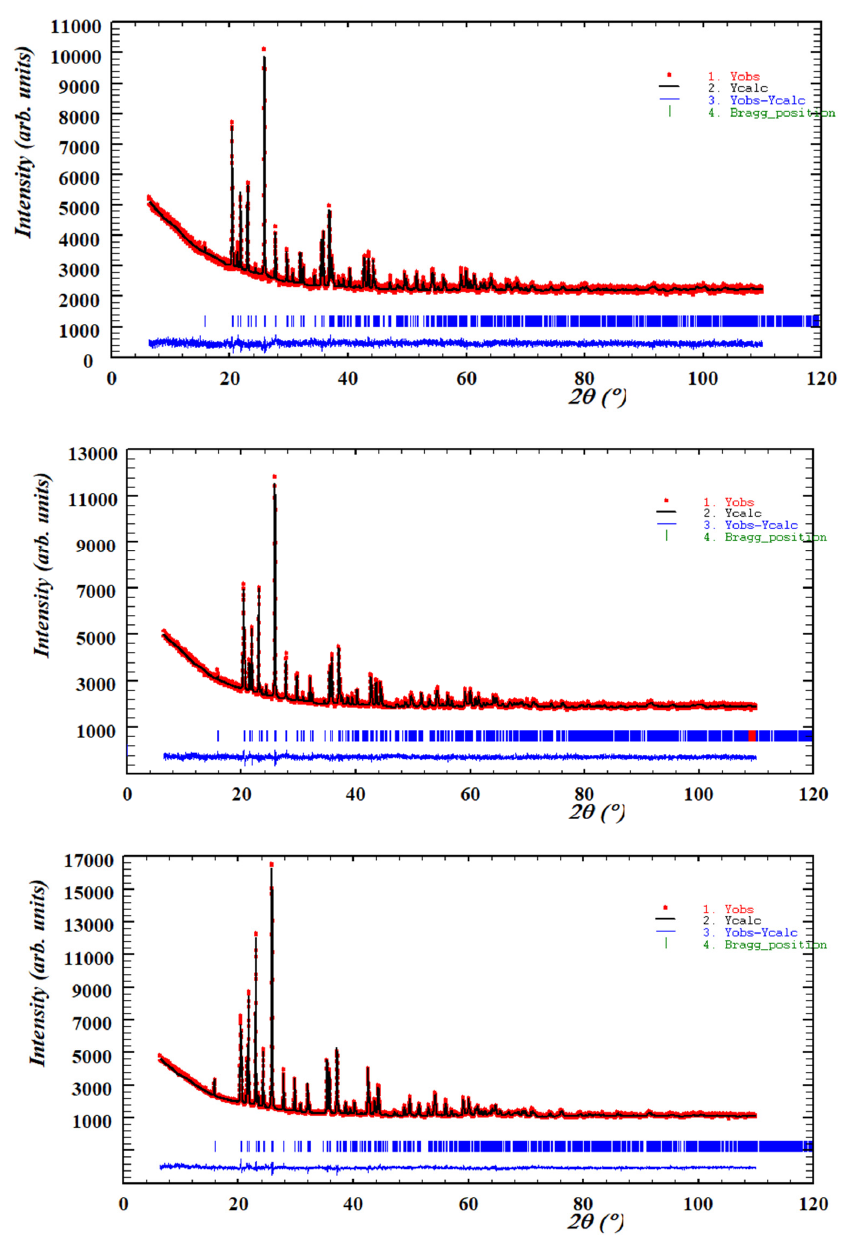
Figure 2. The diffraction profile refinement obtained with Rietveld’s method for the Mg 0.5 Co 2.5 P 2 O 8 (x = 0.5), Mg 1.5 Co 1.5 P 2 O 8 (x = 1.5) and Mg 2.5 Co 0.5 P 2 O 8 (x = 2.5) compositions fired at 1000 °C.